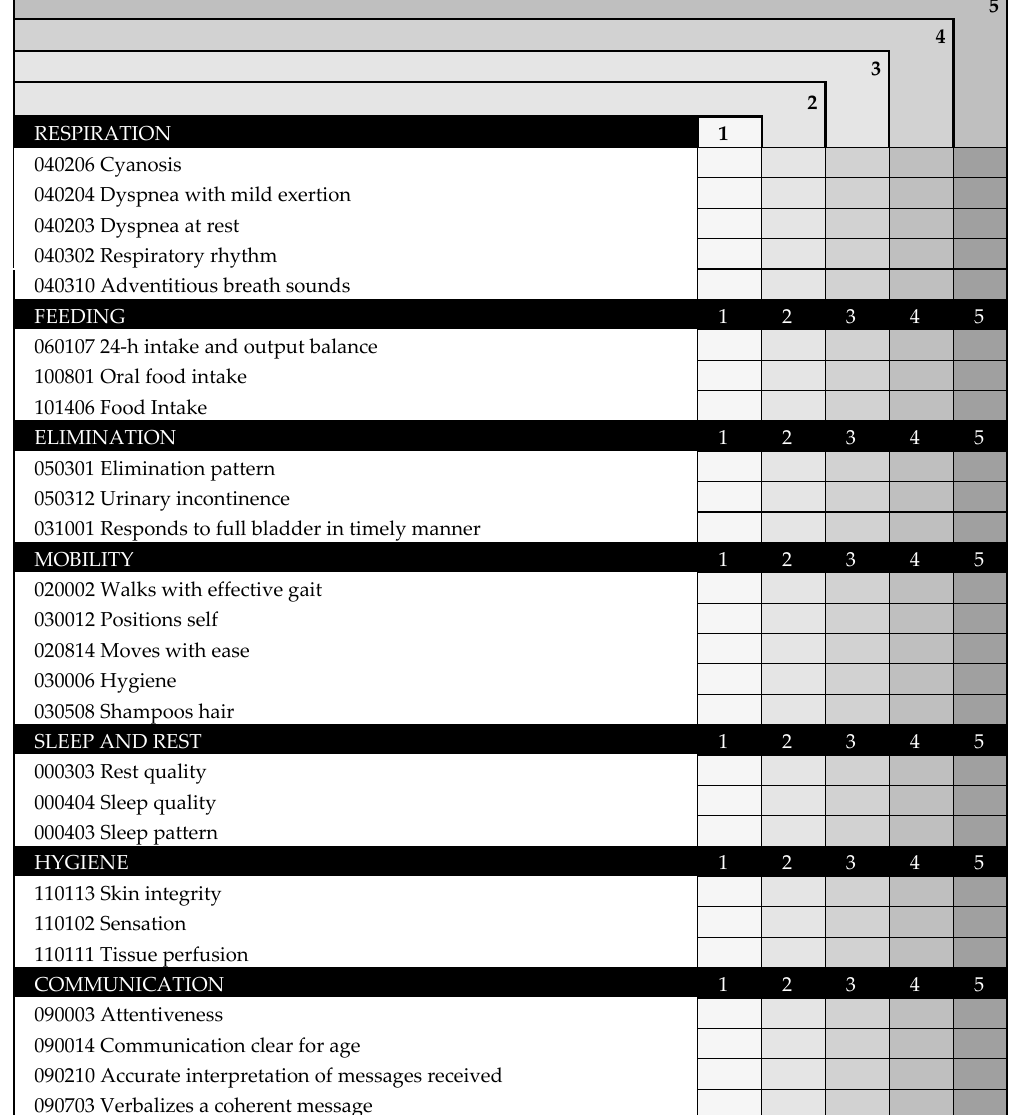
Figure 5. INICIARE-40 English Version.